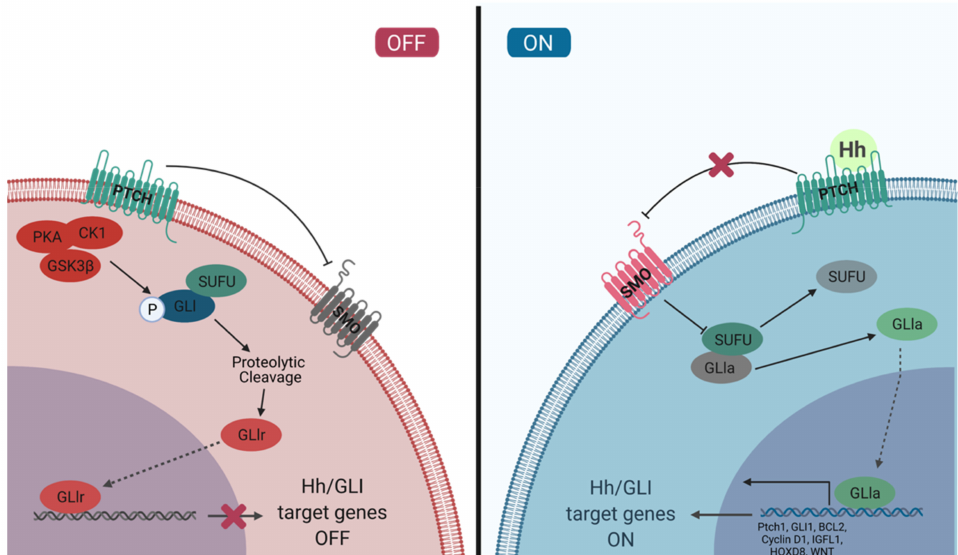
Figure 1. Activation of the Hh/GLI signaling pathway. Left panel: In the absence of ligand binding, PTCH exerts repressive effects on SMO. GLI transcription factors are sequestered by SUFU and phosphorylated by PKA, CK1, and GSK3 β , marking them for proteolytic cleavage. The cleavage of the C-terminal domain creates GLIr, the repressor form of the transcription factor. GLIr then translocates into the nucleus and represses the transcription of Hh/GLI target genes. Right panel: Hh ligand binding to the extracellular domain of PTCH inhibits the receptor, relieving the repressive effects on SMO. SMO then inhibits the sequestration by SUFU and phosphorylation by PKA, CK1, and GSK3 β , sparing GLI from proteolytic cleavage. The full-length form of GLI is a transcriptional activator that translocates into the nucleus and promotes the transcription of Hh/GLI target genes such as PTCH1, GLI1, BCL2, Cyclin D1, IGFL1, HOXD8, and WNT. The canonical Hh/GLI signaling pathway is most typically restricted to the primary cilium, however aberrant activation of this pathway may occur in alternate cellular compartments such as the cell